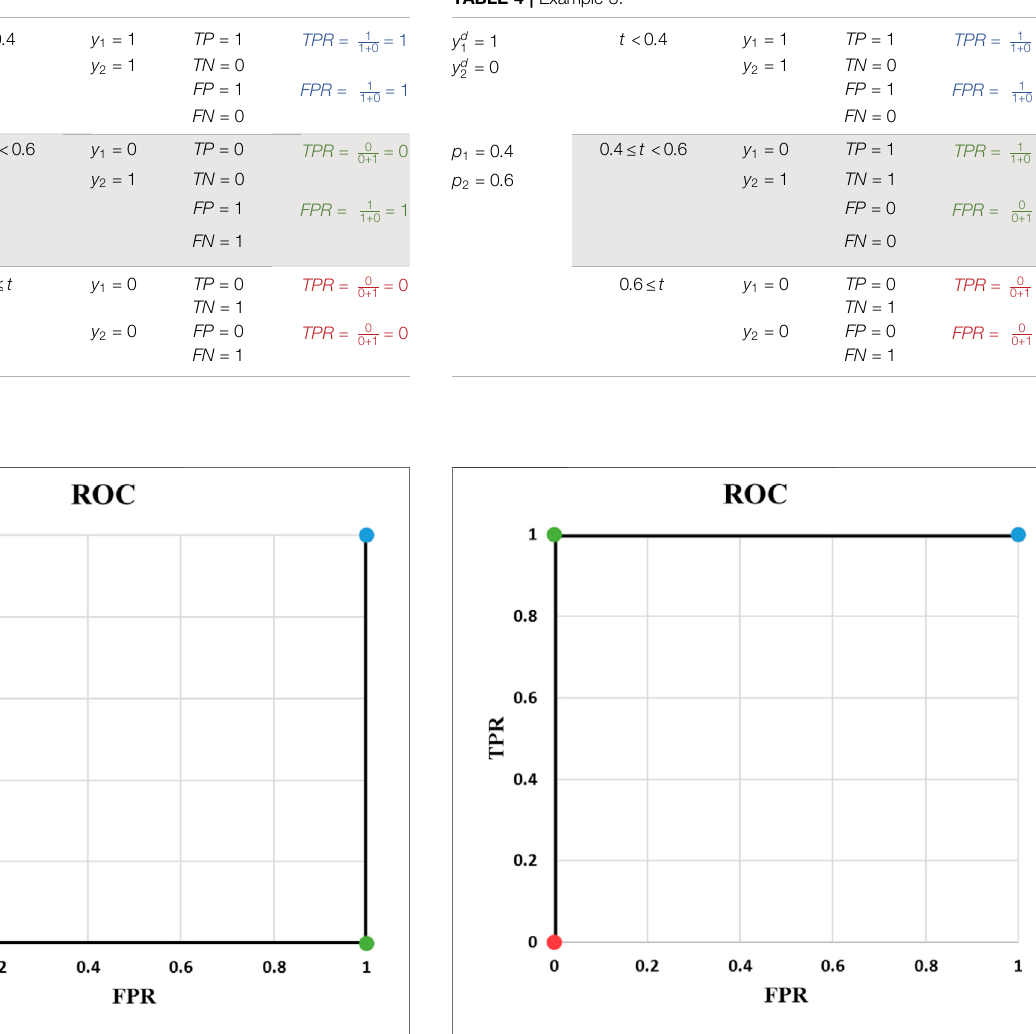
FIGURE 2 | ROC of Example